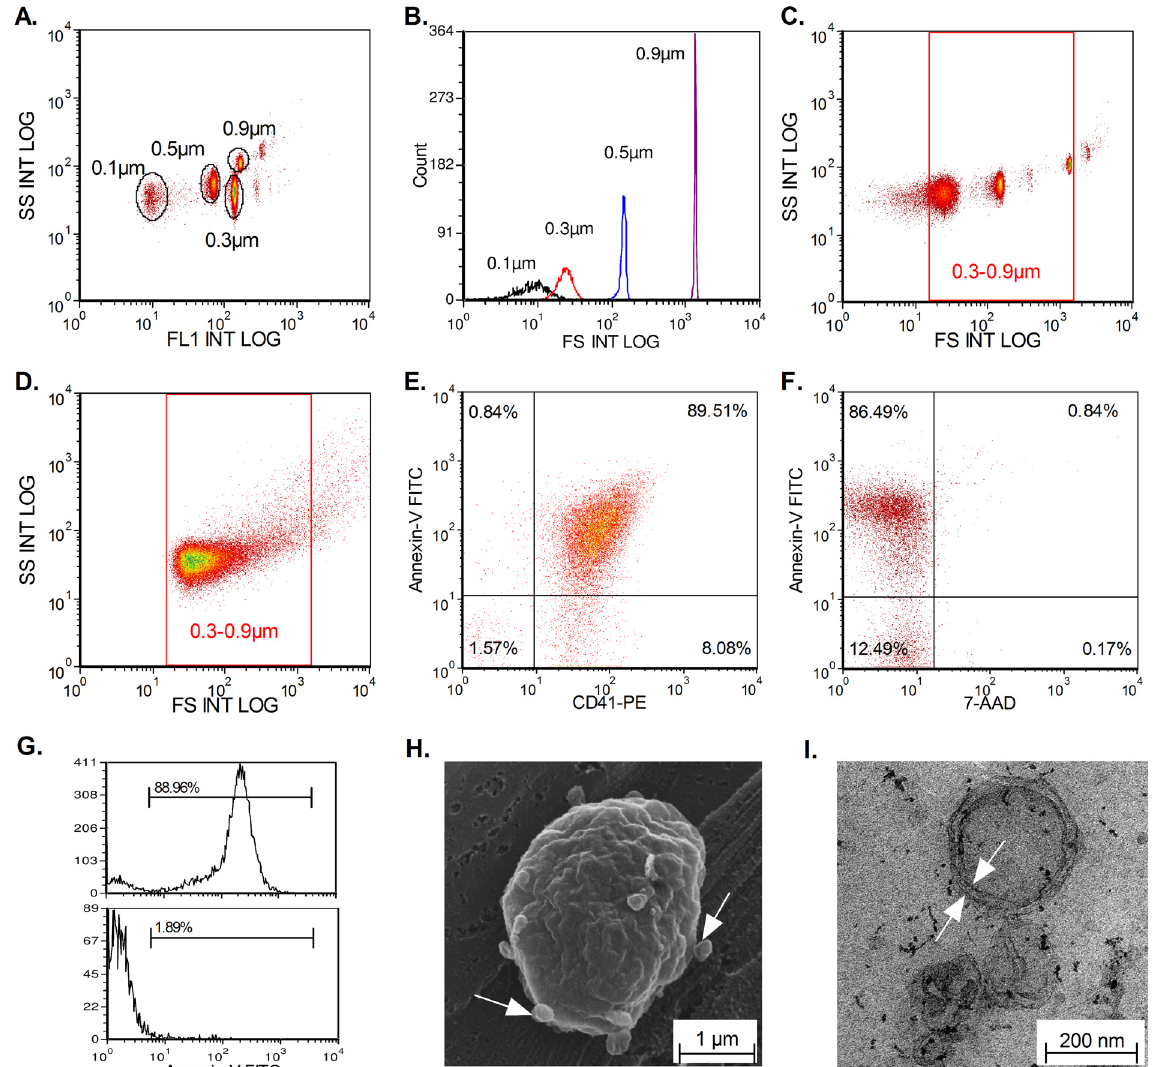
Fig 1. MP analysis by flow cytometry and electron microscopy. Calibration of Navios cytometer using 0.1, 0.3, 0.5, and 0.9 μ m beads (Biocytex). The cytometer is able to differentiate the 4 different populations of beads (A-B). We can delimit the gate in accordance with size to study MPs (0.3 – 0.9 μ m) (C). Characteristic elongated shape of MPs repartition limited in a gate of 0.3 – 0.9 μ m. (D). Labeling of platelet derived-MPs with CD41 and annexin-V revealed a double positive population for these markers (E). Example of 7-AAD/annexin V labeling to detect the presence of apoptotic bodies (AB). (F). Absence of contamination with AB. To monitor the presence of protein complexes (PC), lysis with 0.05% triton was used. After lysis, the positive signal disappeared (G). Scanning Electron Microscopy (SEM) shows the production of MPs by B-lymphocytes (white arrows) (H). Transmission electron microscopy (TEM) shows the structure of one MP with a characteristic lipid bilayer (white arrows)